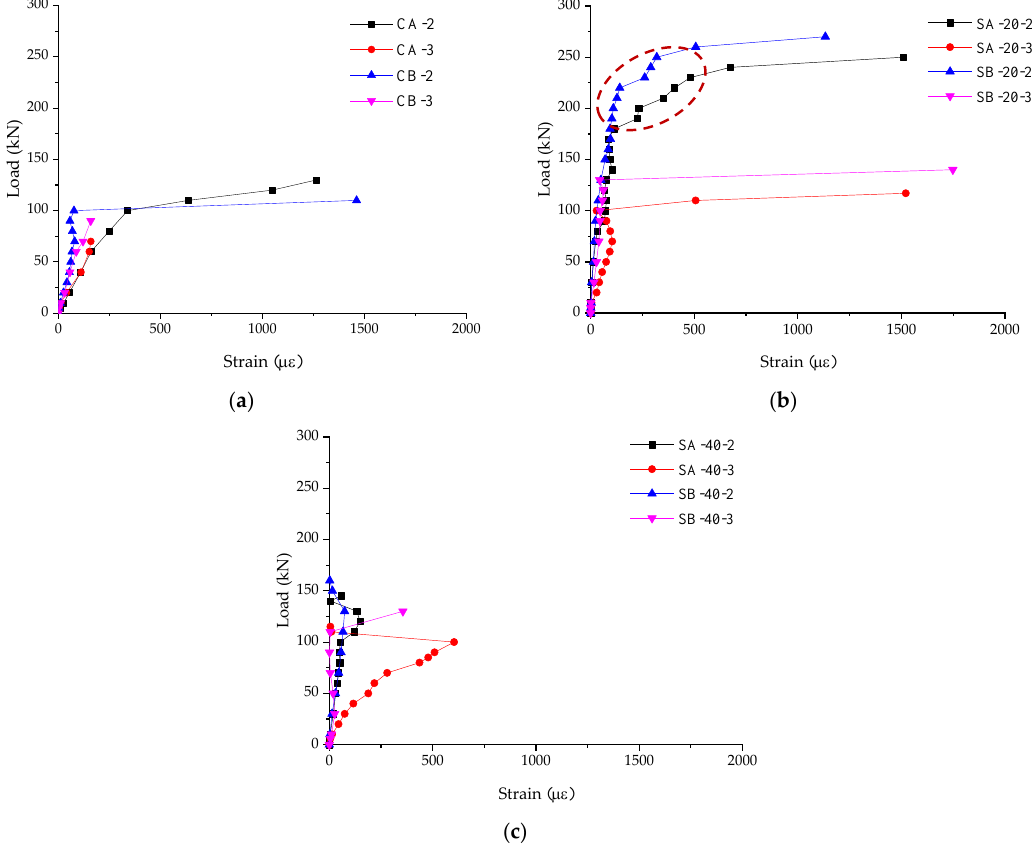
Figure 5. Shear strains in the side of the specimens. ( a ) Control specimens; ( b ) Specimens strengthened